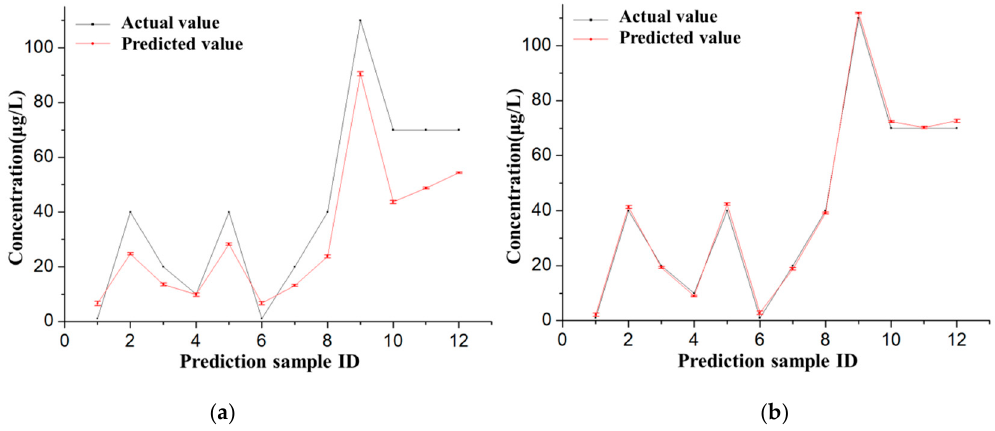
Figure 7. The comparison of prediction results between ( a ) the direct calibration model and ( b ) the ANN model.